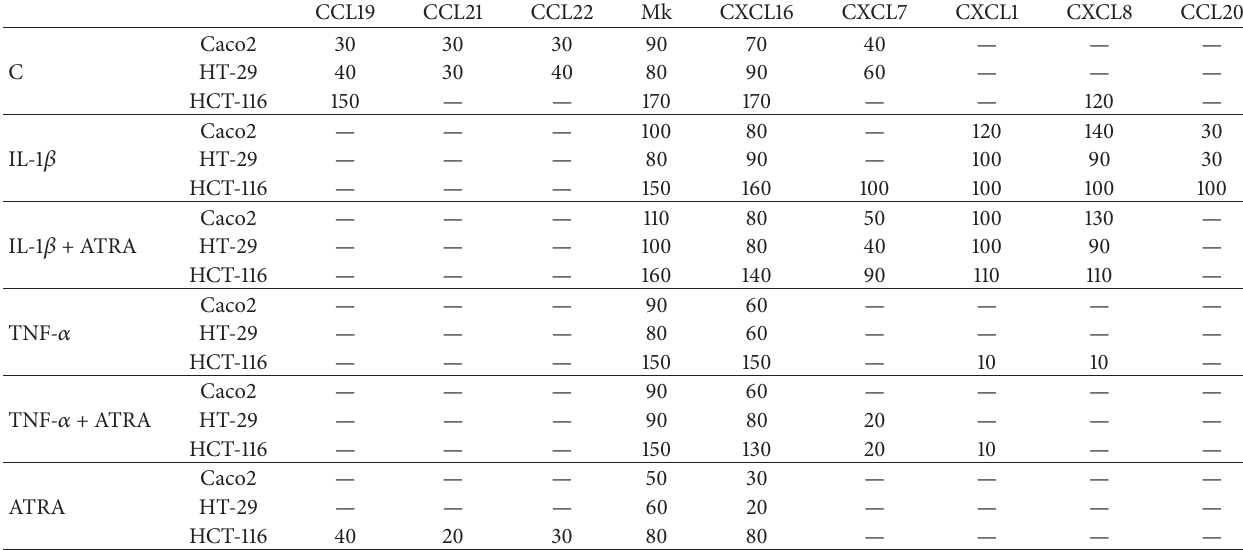
Table 1: Relative expression of chemokines secreted by colon epithelial cell lines. Caco2, HT-29, and HCT116 cells were treated with IL-1 𝛽 or TNF- 𝛼 in the presence or absence of ATRA for 60min. After removing the cell culture supernatant the cells were washed and replaced with fresh medium and the supernatants were collected after 5 hours and used for the Chemokine Array analysis according to the manufacturer’s instruction to determine the variety of chemokines secreted by these cell lines. The values indicate the results of the densitometric analysis of dot blots and are normalized to the relevant sample control according to the manufacturer’s instructions. For simplicity the value of 1 obtained after dividing with the sample control is referred to as